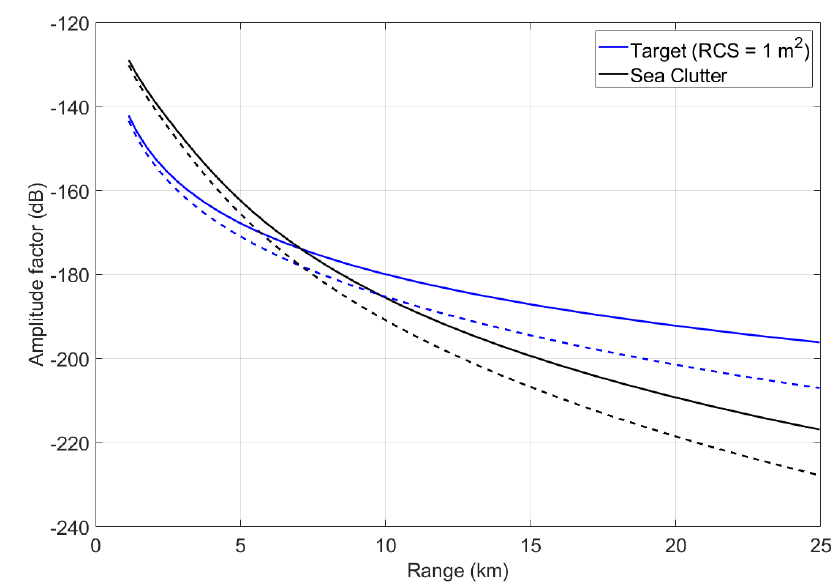
Figure 7. Amplitude factors versus detection range.